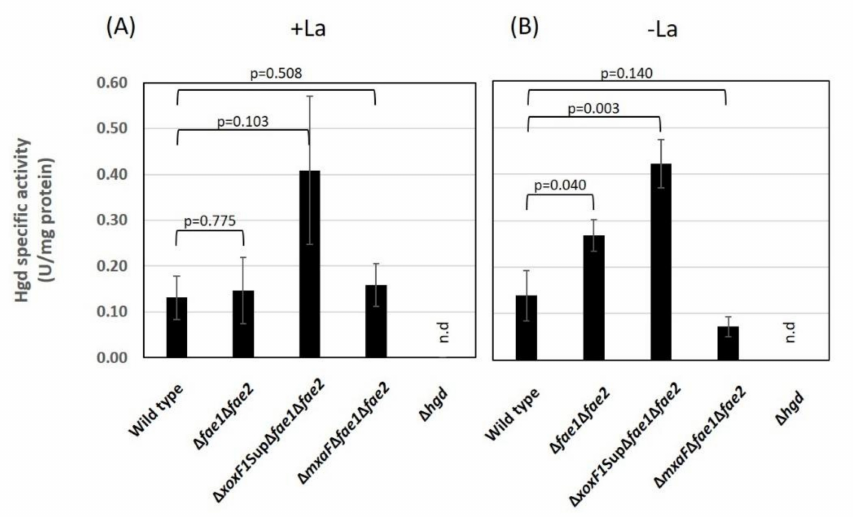
Figure 6. Hgd activity in the cell-free extracts of the wild-type, ∆ fae1 ∆ fae2 , ∆ xoxF1 Sup ∆ fae1 ∆ fae2 , ∆ mxaF ∆ fae1 ∆ fae2 , and ∆ hgd , grown on methanol plus succinate in the ( A ) presence and ( B ) absence of La 3 + . Filled bar, + La 3 + ; open bar, -La 3 + ; n.d., not detected. The results are presented as the average ± SD (biological triplicates). Statistical tests were done with ANOVA and Tukey’s multiple comparison test independently for each dataset (presence / absence of La 3 + ), and p values for the comparisons with the wild-type data are